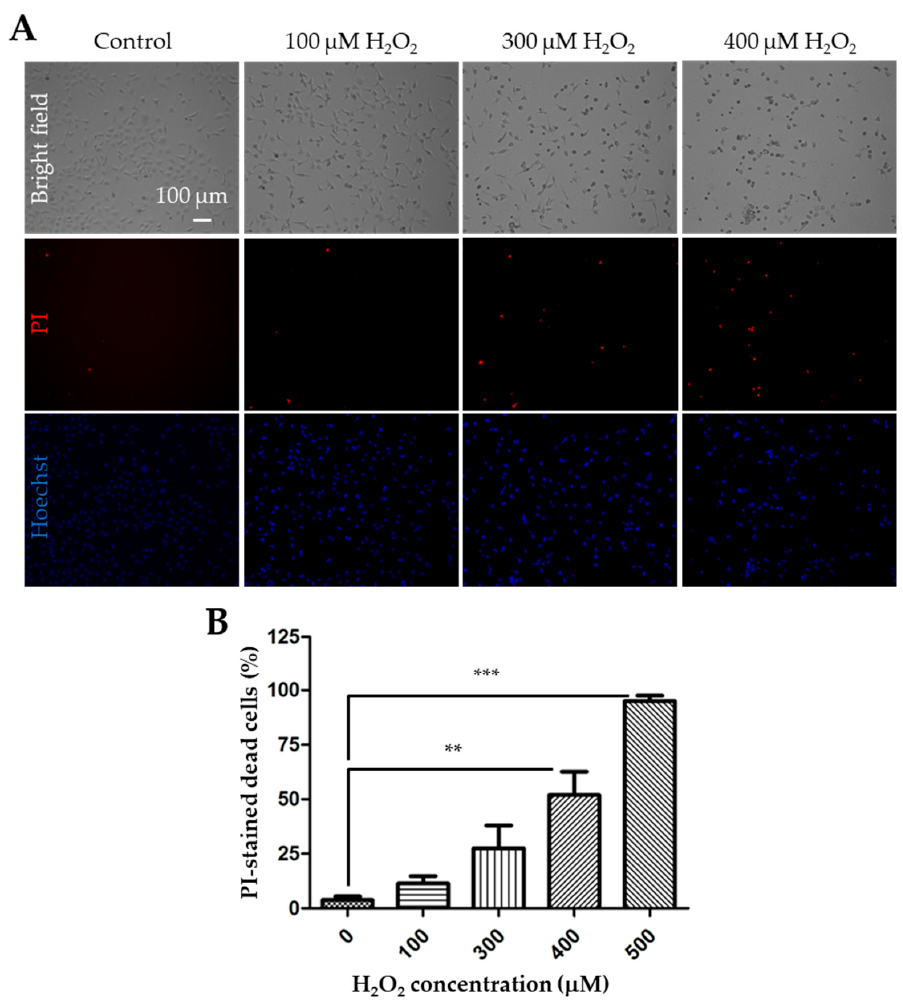
Figure 1. Exposure to H 2 O 2 induces concentration-dependent cell death in SH-SY5Y cells. ( A ) Representative bright field and fluorescence images showing propidium iodide (PI) and Hoechst staining in control cells and cells after exposure to 100, 300 or 400 µ M H 2 O 2 for 24 h. ( B ) Mean ± standard error mean (SEM) percentage of cell death after exposure to indicated concentrations of H 2 O 2 from 3 independent experiments. **, p < 0.01 and ***, p < 0.001, compared to control cells without exposure to H 2 O 2 .